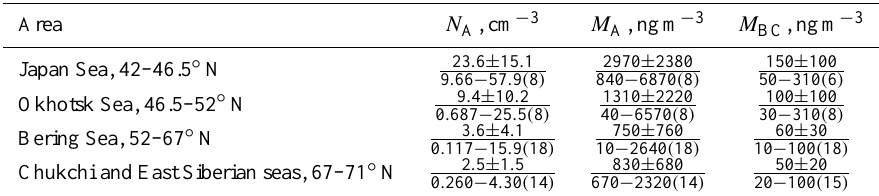
Figure 8. Latitudinal distribution of parameters N A , M A , and M BC in Far East seas: asterisks indicate the linear regression, and thick lines indicate the average values within separate latitude zones. Table 5. Statistical characteristics of aerosol in Far East seas: the numerator indicates mean and standard deviation ( ± SD); and the denomi- nator indicates the minimum (min), maximum (max) values, and the number of measurement days ( n